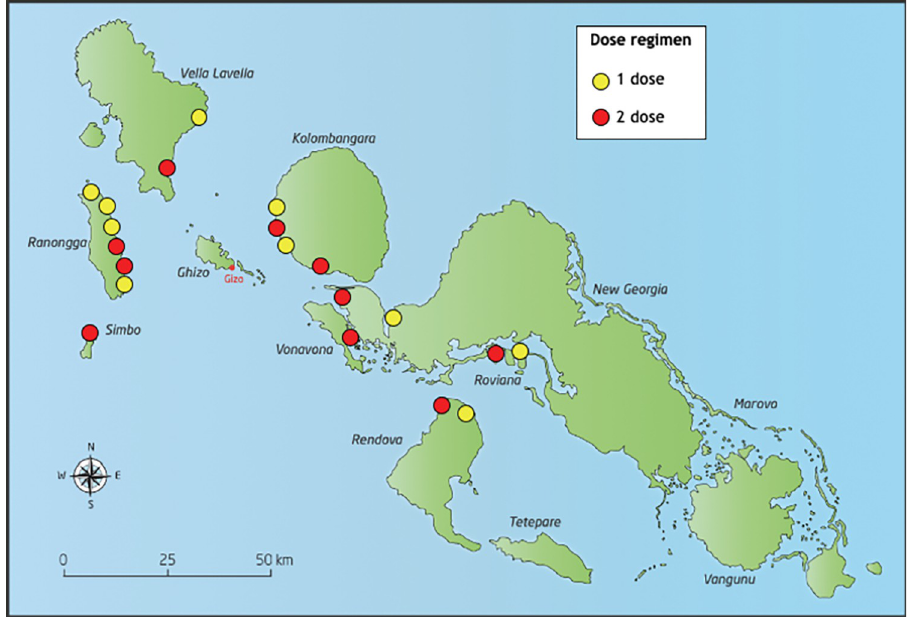
Fig 1. Map of study villages in Western Province, Solomon Islands. Yellow dots identify villages in Arm 1 (1 dose) and red dots identify villages in Arm 2 (2 doses). ( The map in this figure was drawn by Hilary Bruce at Murdoch Children’s Research Institute and adapted by the authors of the manuscript. The source that was used to create the map is freevectormaps.com, https://freevectormaps.com/solomon-islands/SB-EPS-02-0001. The authors understand and agree to the terms of the Creative Commons Attribution